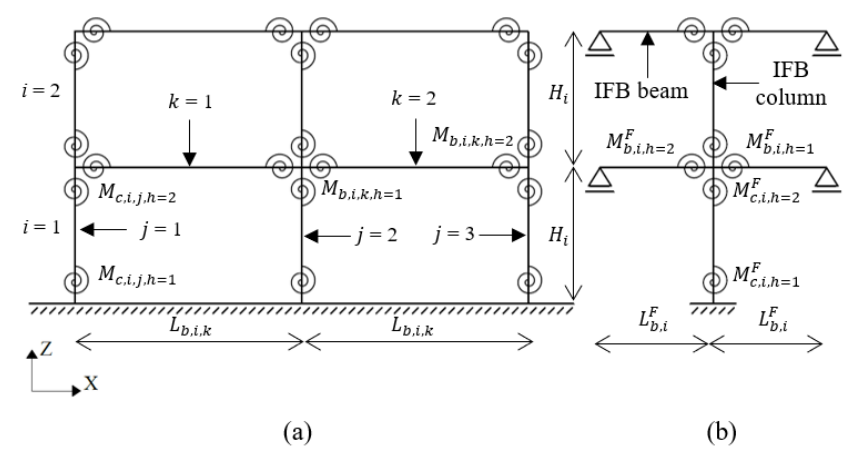
Figure 3. Schematic presentation of ( a ) the MDOF model and ( b ) the IFB model with the indication of characteristic moments of the plastic hinges and the corresponding indices.